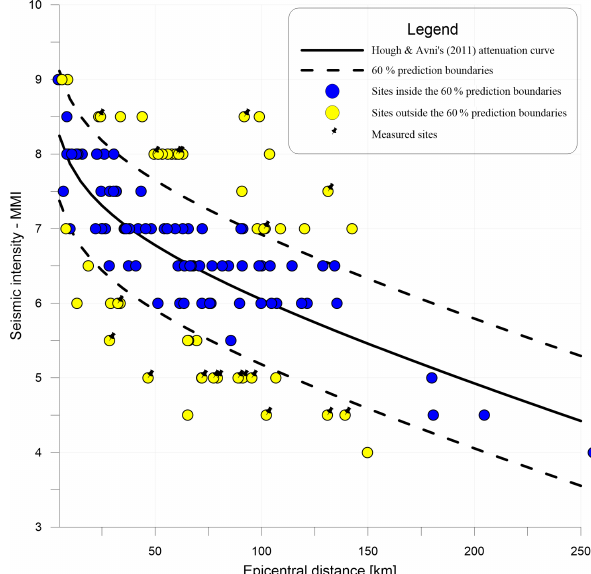
Figure 8. Avni’s seismic intensity (MMI) estimates of all the 133 sites. Distance is corrected according to the Zohar and Marco epi- center. Yellow dots are suspected amplified or de-amplified sites. Sites with pins are sites where we measured the V s profile. Blue dots are sites which have MMI values expected from the attenua- tion equation (within the 60% prediction